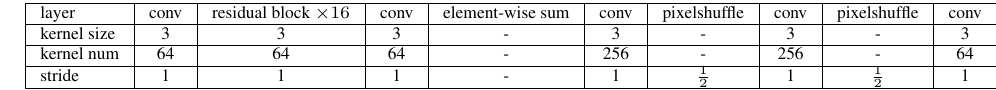
Table 2. Architecture of upsampling Generator G S . detector